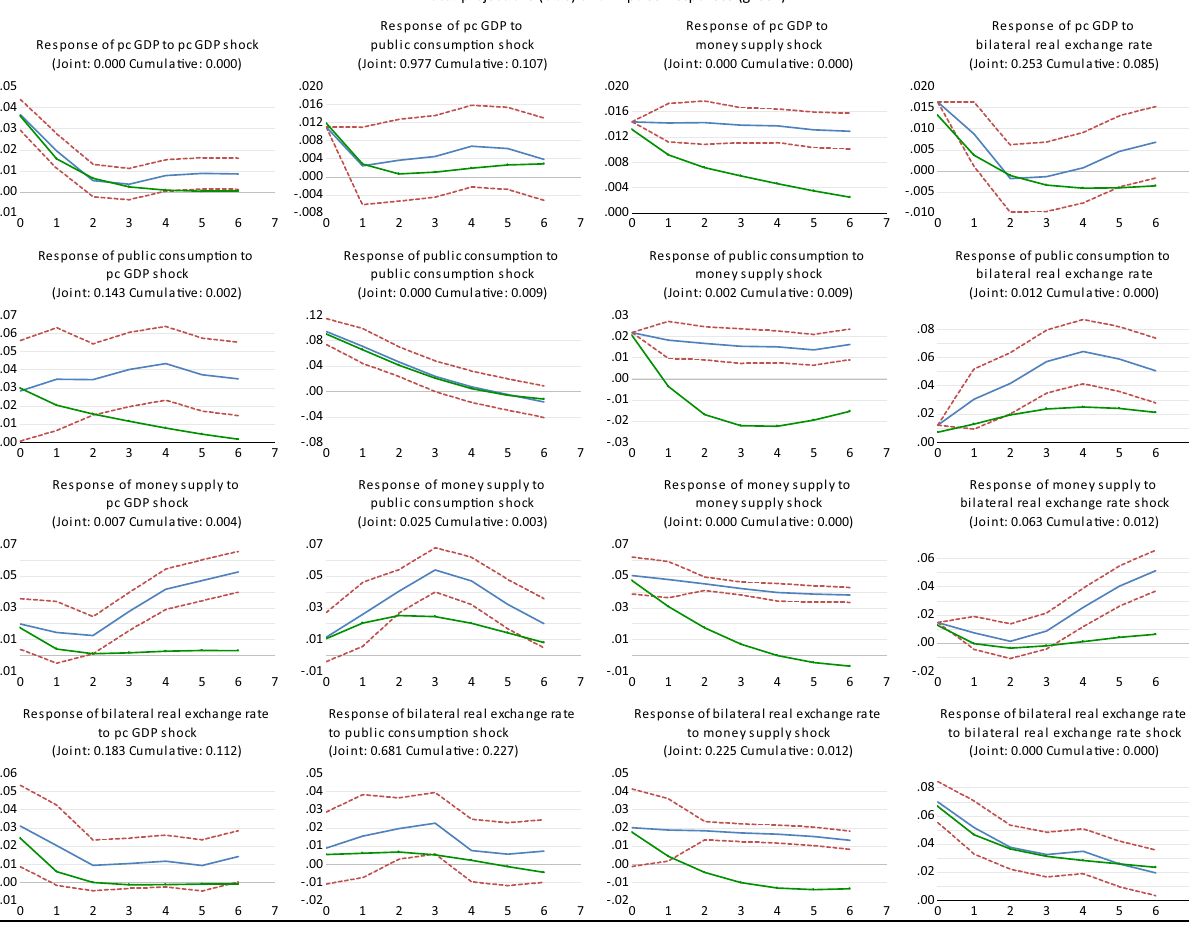
Figure 5: Impulse response function ( Spain )